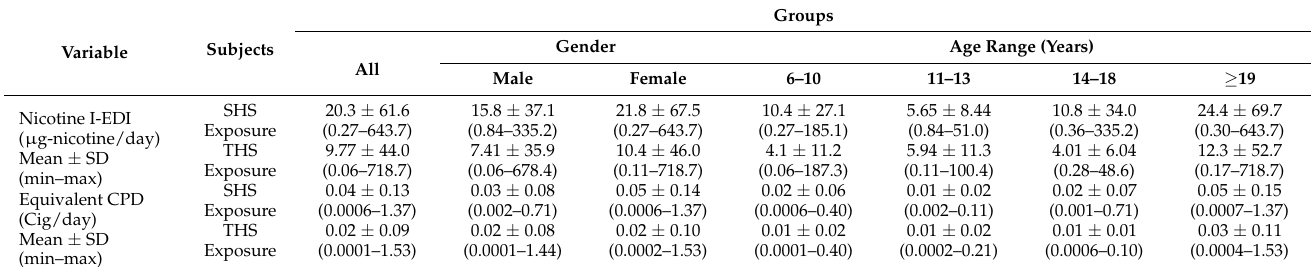
Table 5. Results of nicotine I-EDI and equivalent CPD for ETS exposure